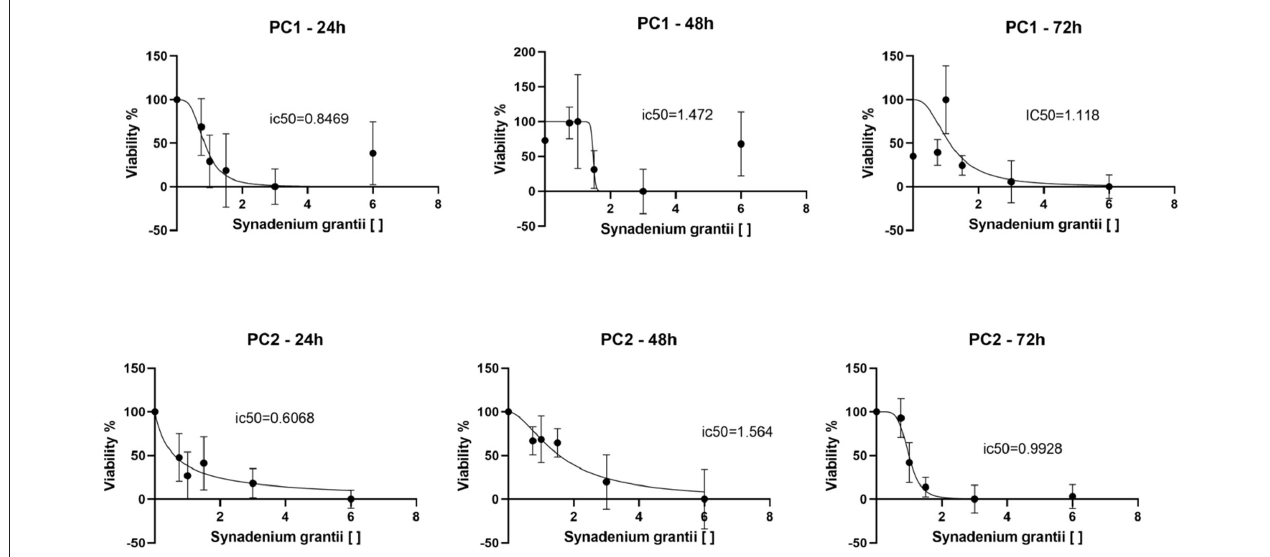
FIGURE 3 | Determination of IC 50 of PC1 and PC2 cell lines at 24, 48, and 72h. The cell lines presented low IC 50 at 24h but high at 48h. Then, at 72h, IC 50 decreased compared to the previous moment. The graphic representation also shows a dose-dependent response trend over